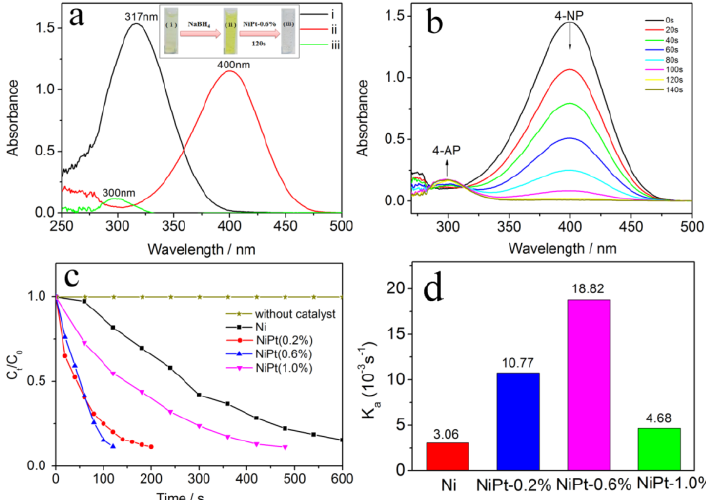
Figure 5. ( a ) Ultraviolet-visible (UV-VIS) absorption spectra of the solution before (i) and after (ii) the